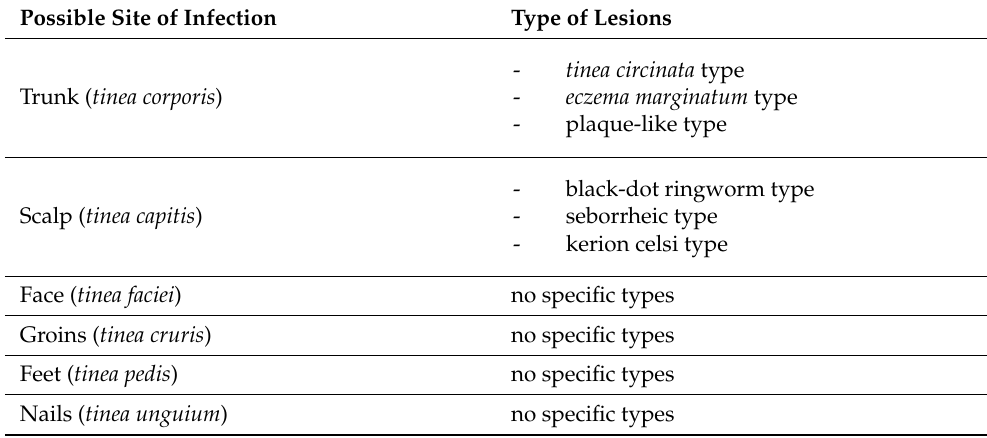
Table 2. Types of lesions according to the possible site of